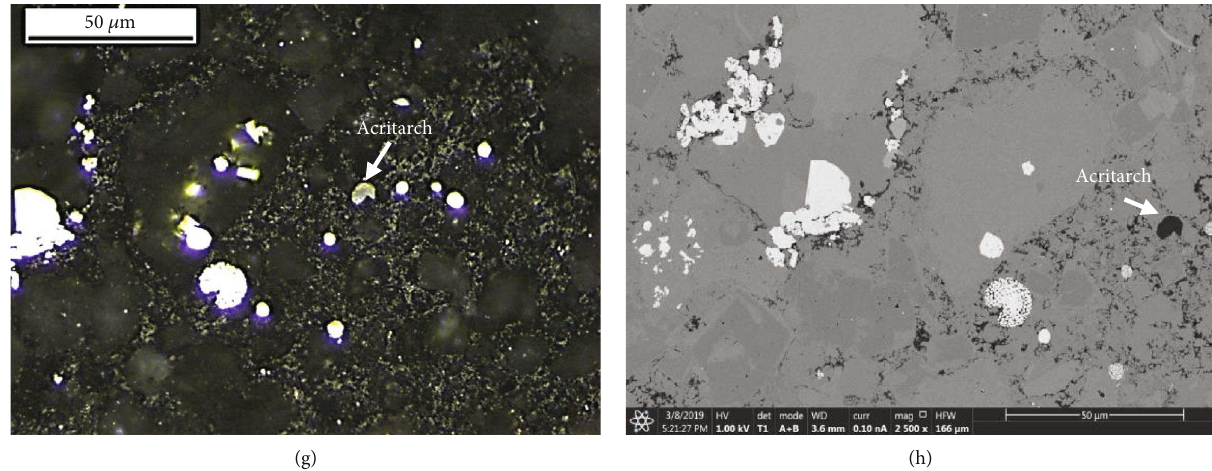
Figure 6: Pyrobitumen and zooclast morphology and distribution under SEM and re fl ected light microscopy in Wufeng-Longmaxi shale. The pairs (a, b), (c, d), (e, f), and (g, h) show the same areas on four di ff erent samples. (a – f) Pyrobitumen occurred as speckles disseminated in the shale matrix. (a – d) Graptolite fragments characterized by biological morphologies with sharp outlines. (b, c) Graptolite with a spindle shape. (e, f) Chitinozoan fragment with a scalene shape. (g, h) Acritarch body and its central cavity closed with irregular